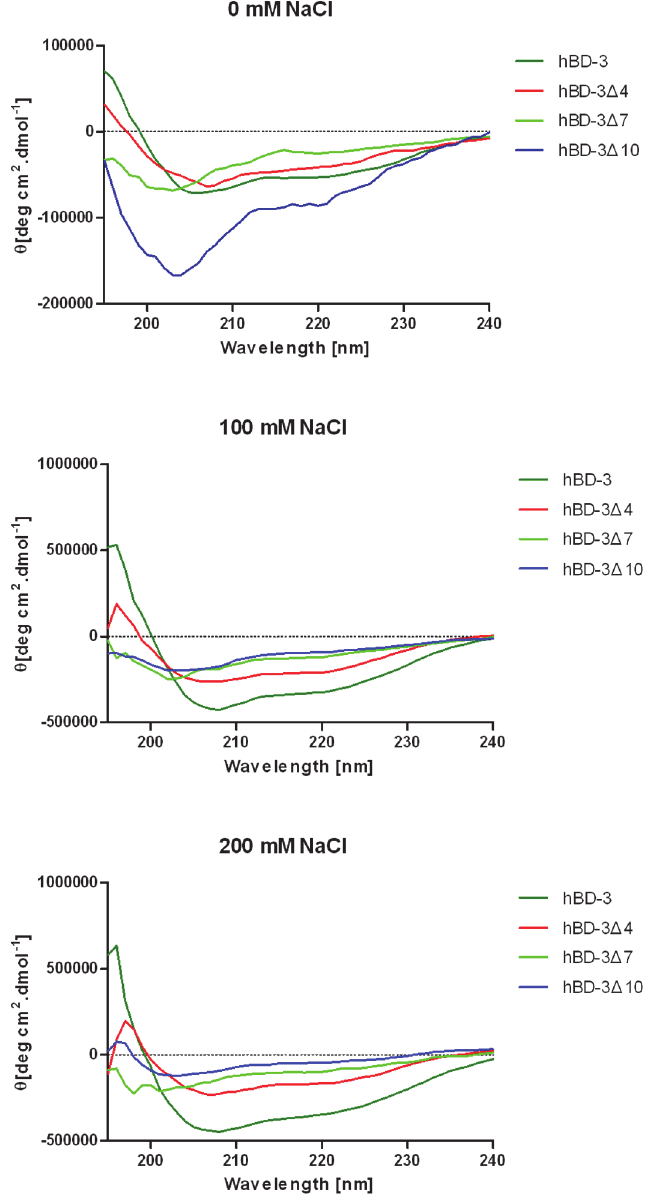
Fig 3. The circular dichroism spectroscopy of hBD-3, hBD-3 Δ 4 and hBD-3 Δ 7 with different NaCl concentrations.